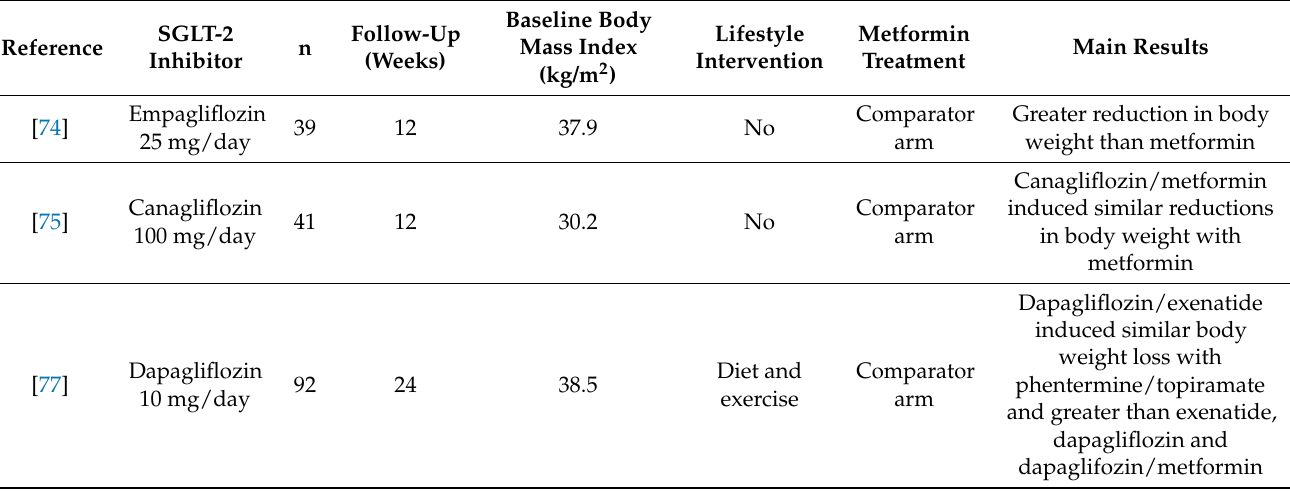
Table 3. Major studies evaluating the effects of sodium-glucose cotransporter-2 (SGLT-2) inhibitors on obesity in patients with polycystic ovary